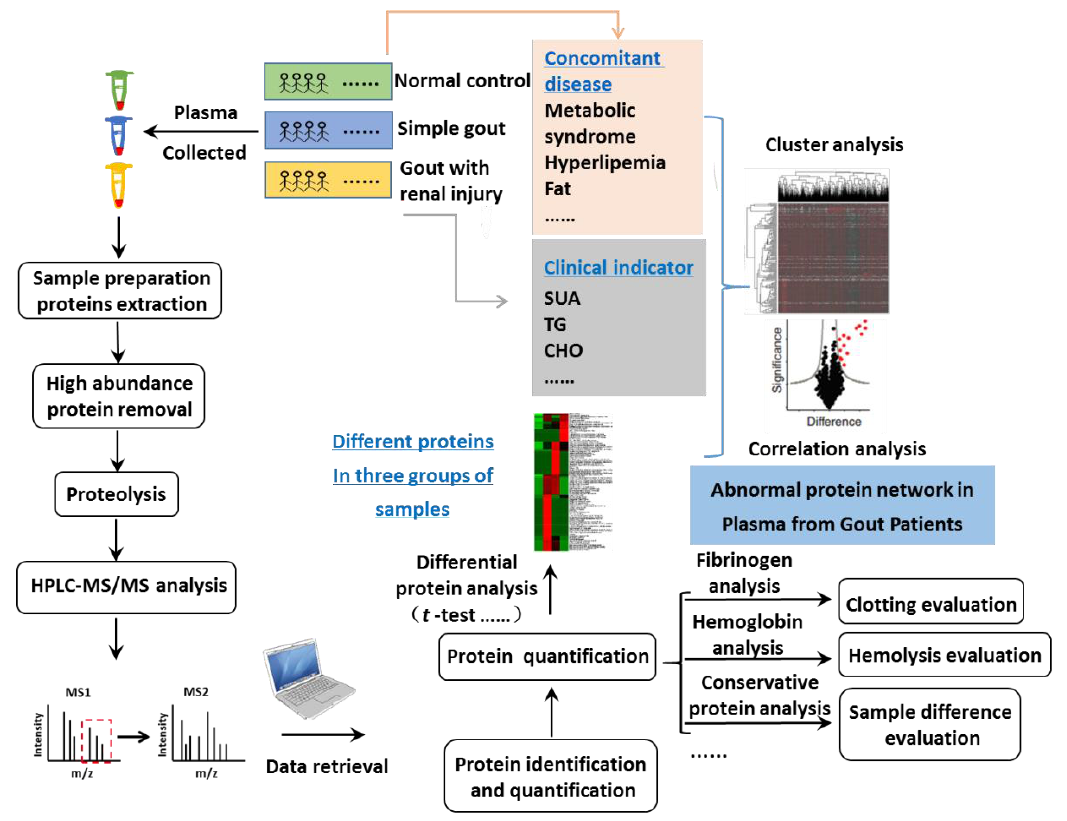
Figure 1. Study design and workflow. The study cohort consisted of 24 individuals. Triplicates of 24 plasma samples resulted in 72 plasma proteomes. The LC-MS/MS data, which we analyzed by